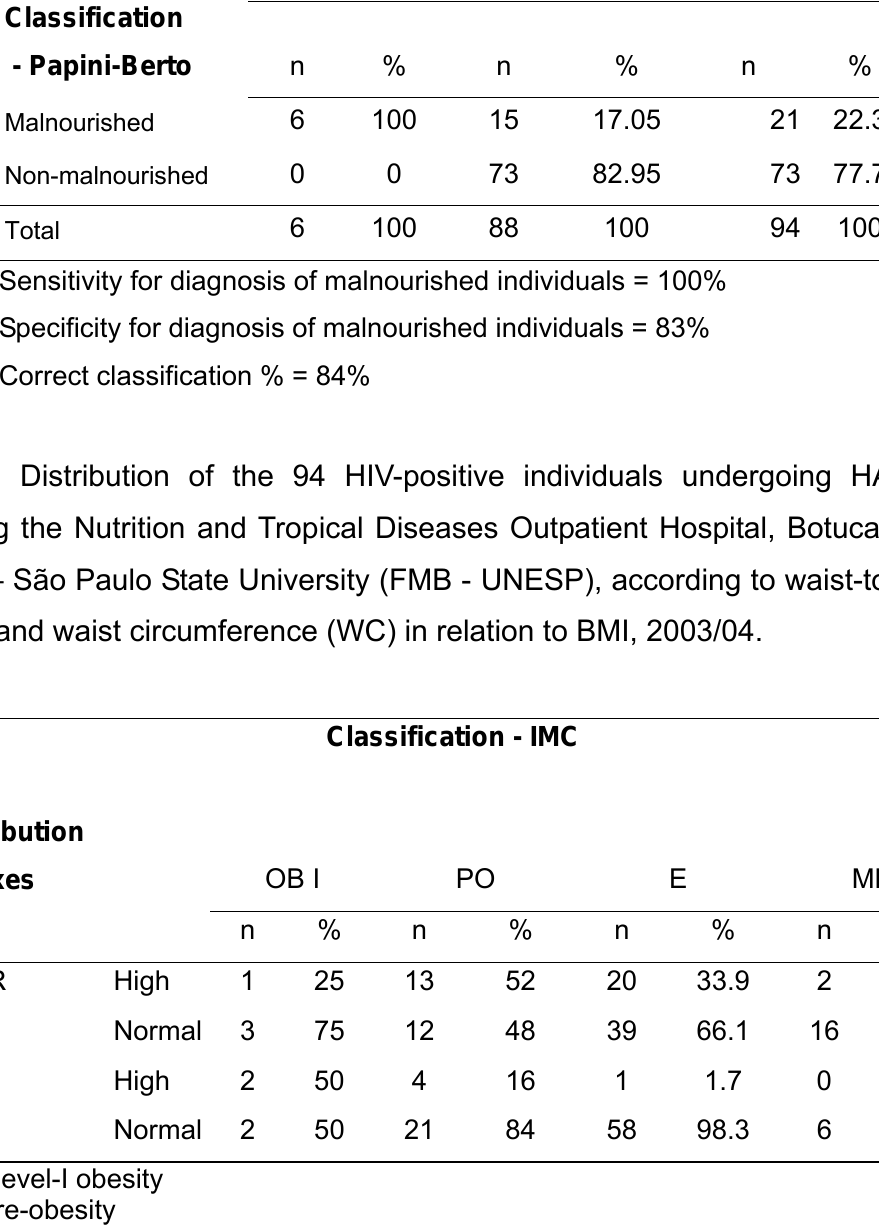
OB I = level-I obesity PO = pre-obesity E = eutrophy MN I = level-I